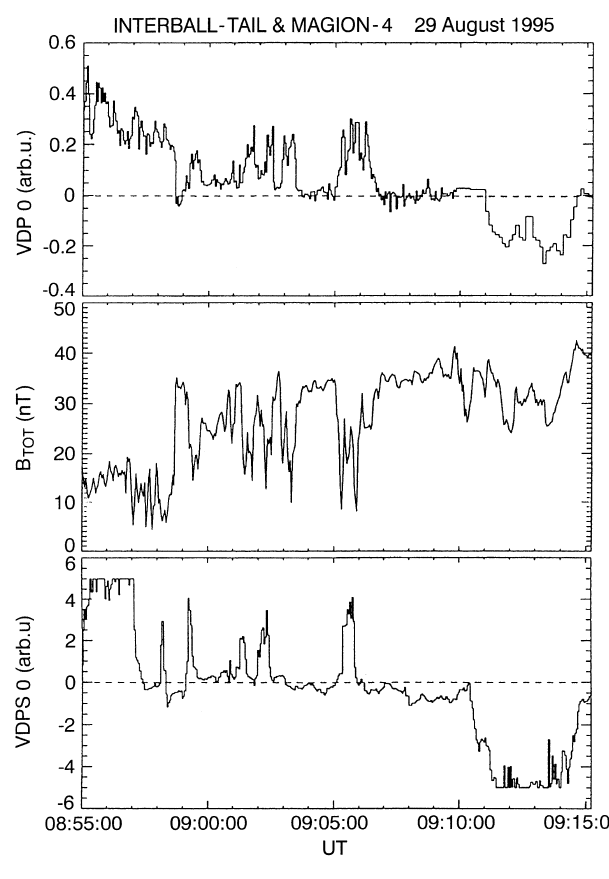
Fig. 5. Faraday’s cup data from INTERBALL 1 ( top panel ) and MAGION-4 ( bottom panel ) and magnetic-field modulus measured by the MIF-M instrument onboard the INTERBALL-1 satellite ( middle panel